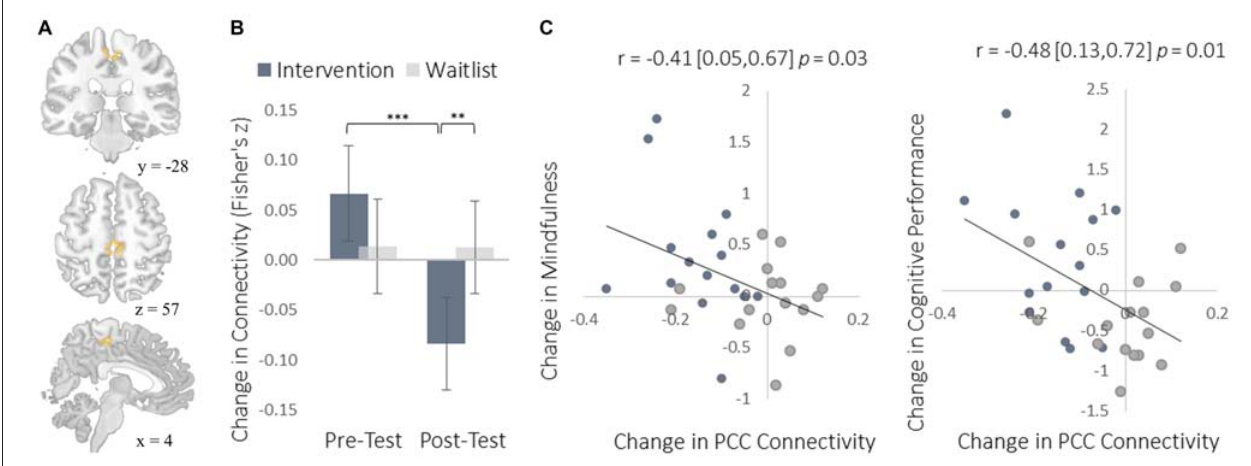
FIGURE 8 | Results for the SMA cluster showing a decrease in functional connectivity with the PCC seed ROIs. (A) The location of the SMA cluster; MNI peak-coordinate: (4, − 26, 52). Cluster forming threshold set at p < 0.001 and cluster size threshold set at p < 0.05 (FDR corrected). (B) Mean Fisher r-to-z transformed functional connectivity values for the intervention and waitlist groups at pre- and post-testing. (C) Scatterplots correlating changes in PCC-SMA functional connectivity with changes in mindfulness and changes in cognitive performance from pre-testing to post-testing. SMA, supplemental motor area; PCC,